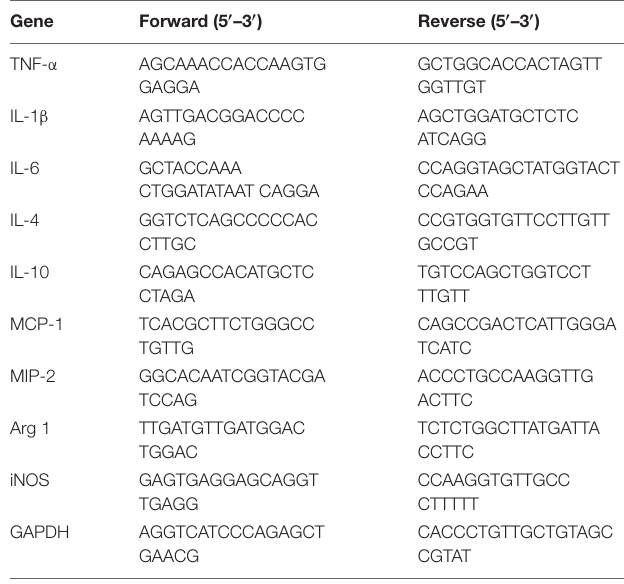
TABLE 1 | Nucleotide sequences of primers used in real-time qRT-PCR. Gene Forward (5 (cid:48) –3 (cid:48) ) Reverse (5 (cid:48) –3 (cid:48)